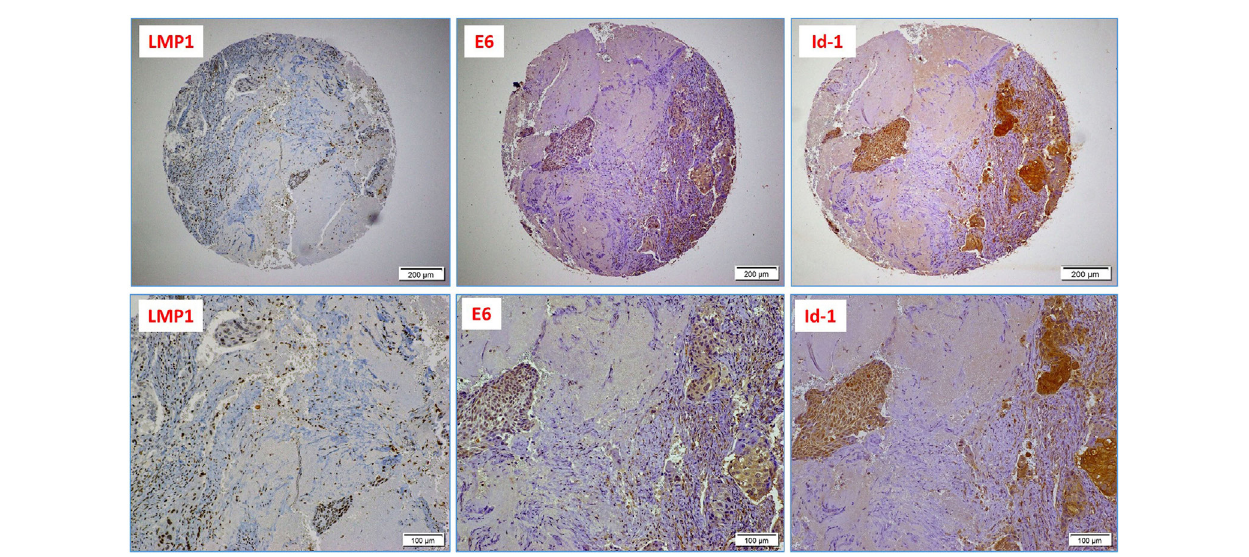
FigUre 2 | A case of poorly differentiated (high-grade, non-keratinizing) cervical carcinoma: upper images highlight the presence of Epstein–Barr virus (EBV) (LMP1 protein), high-risk HPV (E6 onco-protein), and a diffused Id-1 protein expression (10 × magnification); lower images are respective high-power images (20 × magnification); note the presence of EBV-positive tumor infiltrating lymphocytes